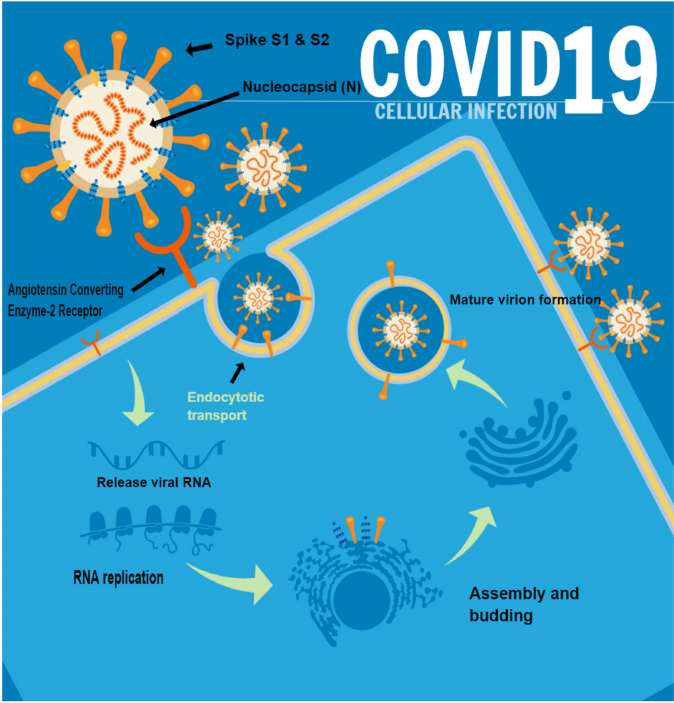
Figure 1. Summary of the SARS-CoV-2 spike protein-binding mechanism to the ACE2 receptor, resulting in virion entry, replication, assembly of new virions and dissemination of new viral particles. It should be noted that this mechanism has also been proposed at the level of keratinocytes and cells constituting the cutaneous eccrine sweat